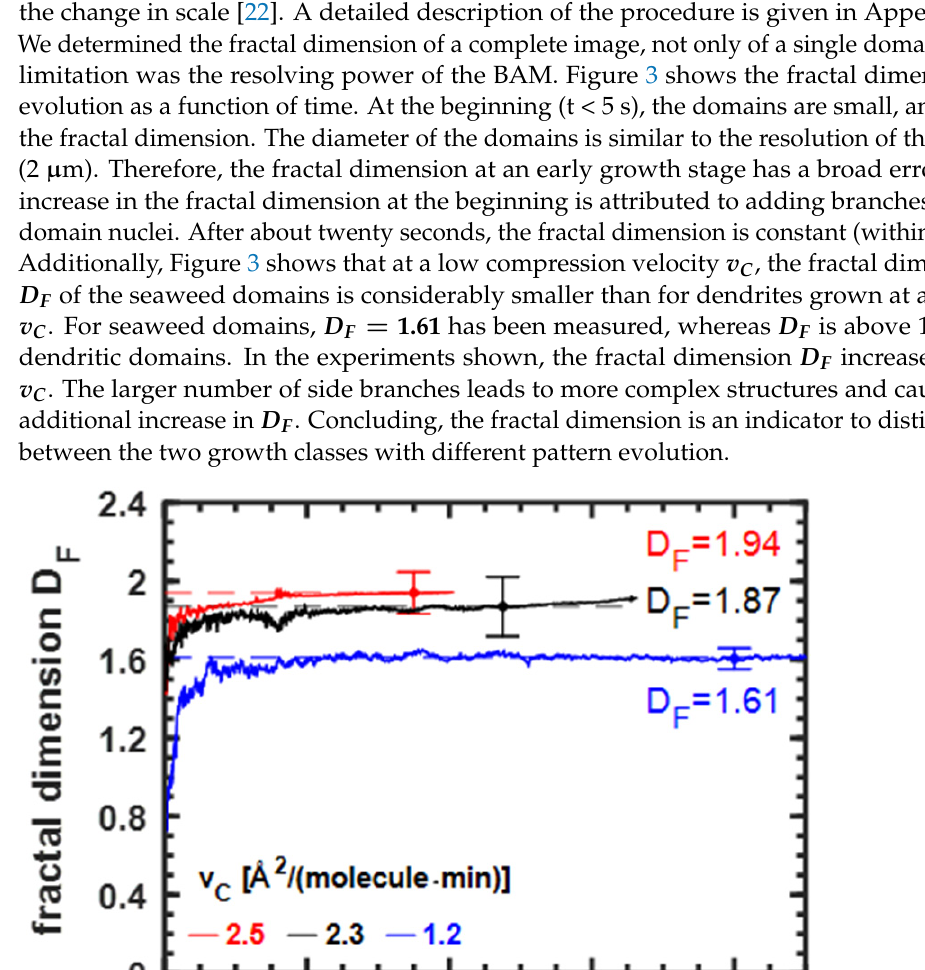
as a function of time (cid:3004)